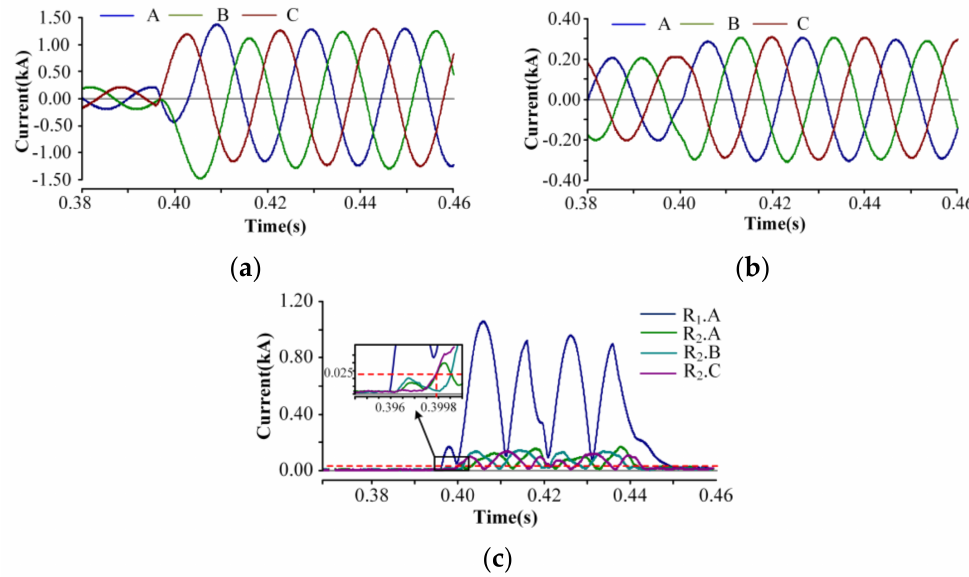
Figure 15. Fault record of a three-phase short-circuit fault with 2 Ω fault resistance occurs at f . ( a ) Currents at R 1 ; ( b ) currents at R 2 ; ( c ) the mutation of A-phase current at R 1 and a three-phase current at R 2 .